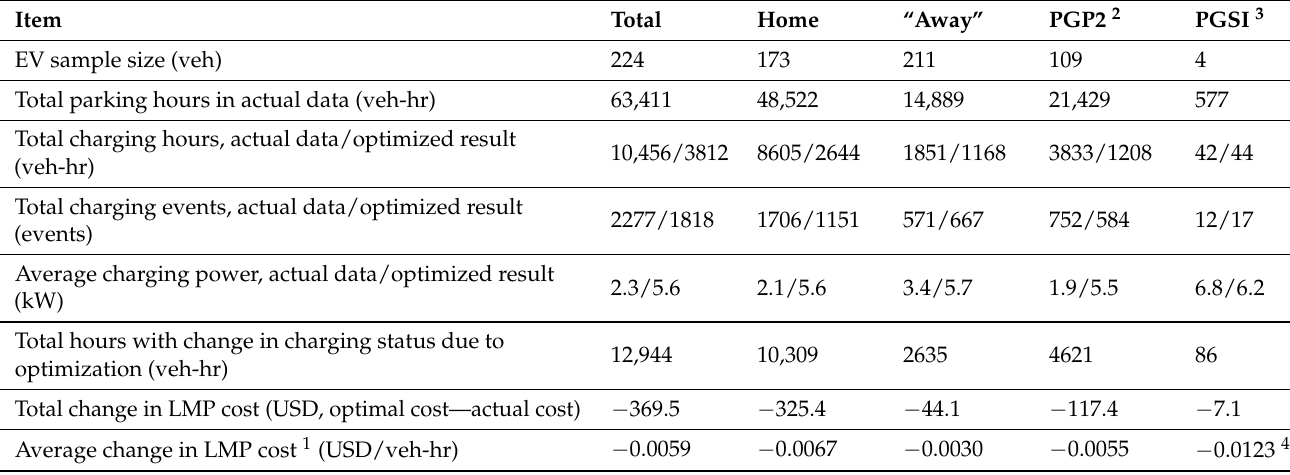
Table 2. Inter-location result with LMP minimization.